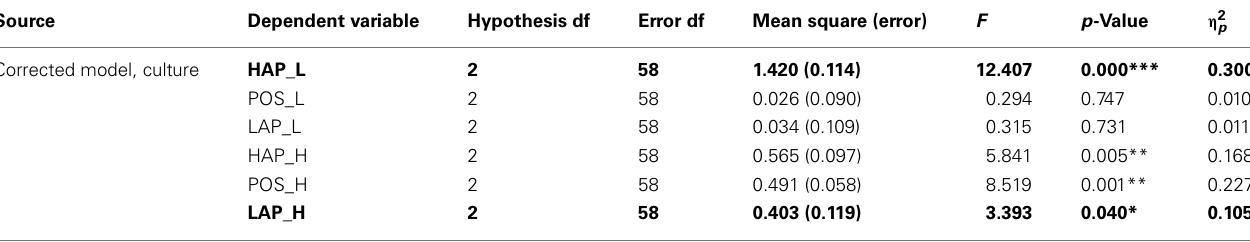
TableA4 | Univariate tests of simple